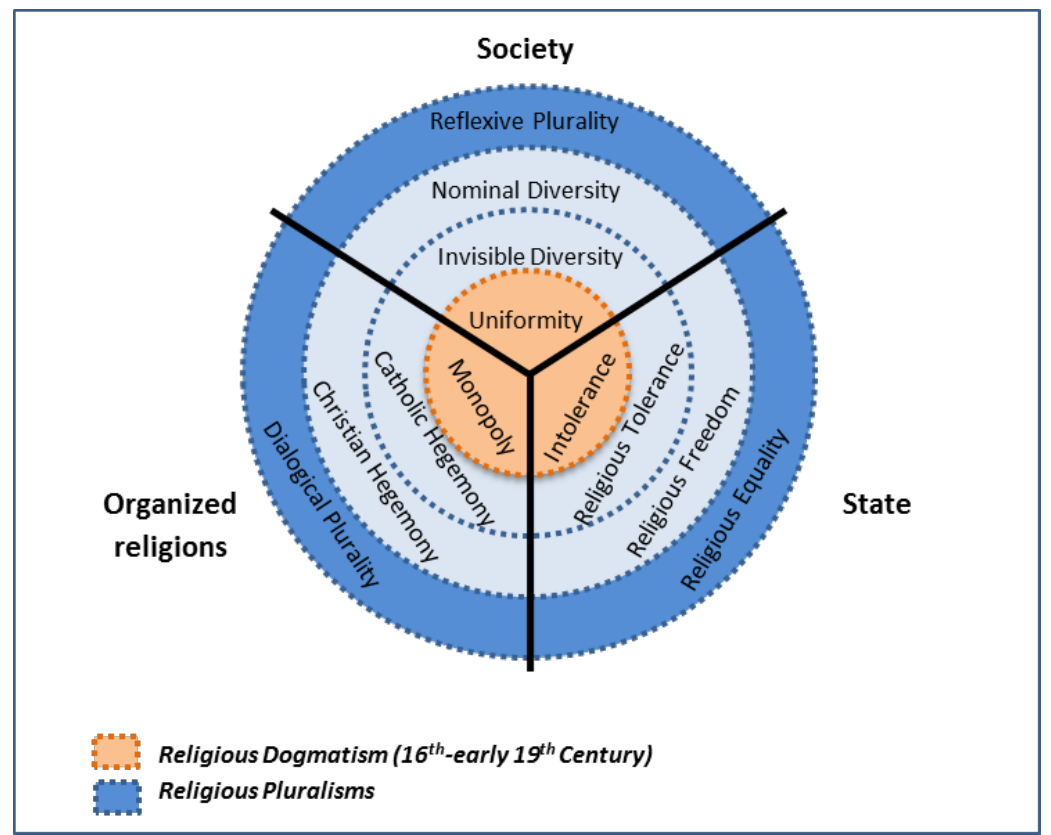
Figure 1. A three-dimensional model of religious